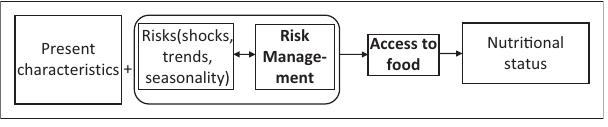
Figure 2 follows on the next page